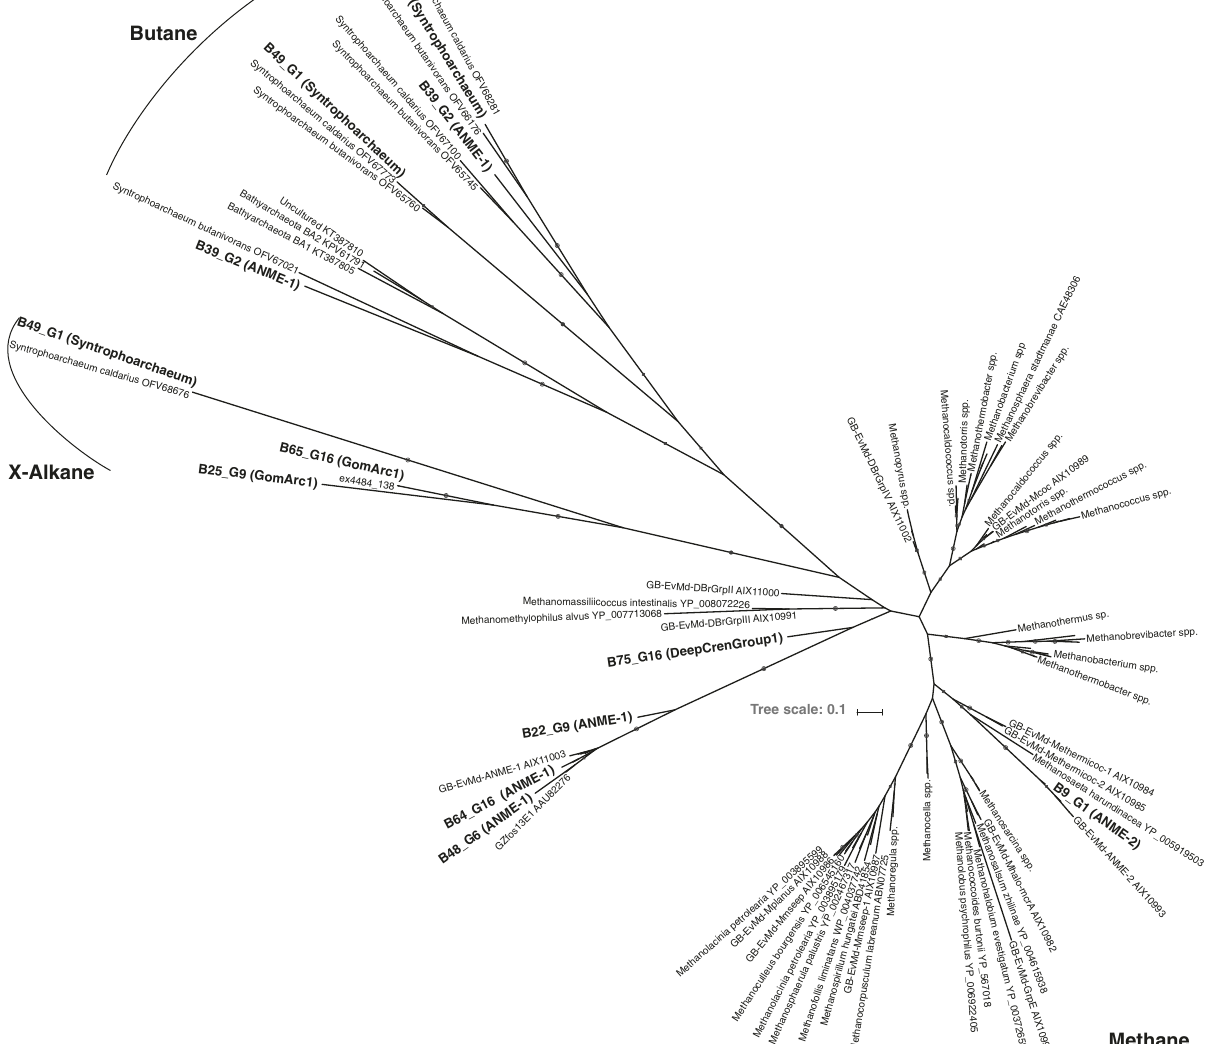
Fig. 5 Maximum likelihood phylogenetic tree of the methyl-Coenzyme M reductase (McrA) protein detected in GB genomes. Bold labels: McrA detected in GB genomes (see also Supplementary Data 10). Black circle: Bootstrap support ≥ 70 (number of bootstraps determined using the extended majority-rule consensus tree criterion). RaxML was run as raxmlHPC-PTHREADS-AVX -f a -m PROTGAMMAAUTO -N autoMRE. The tree fi le is available